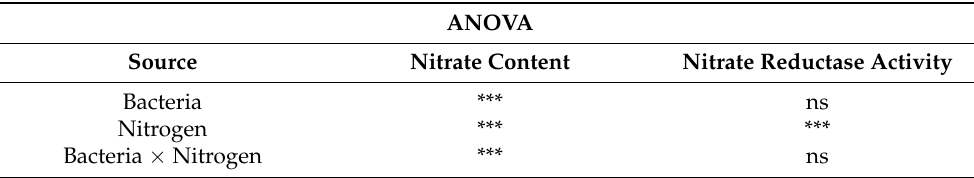
Table 8. Nitrate accumulation and nitrate reductase activity in hydroponically grown lettuce influ- enced by Azotobacter under different nitrogen levels. Significant differences: *** p < 0.001 and ns: